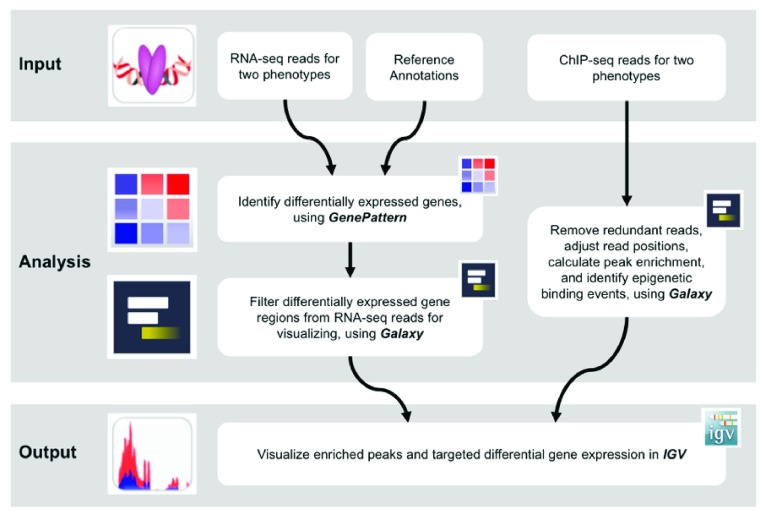
Workflow diagram.